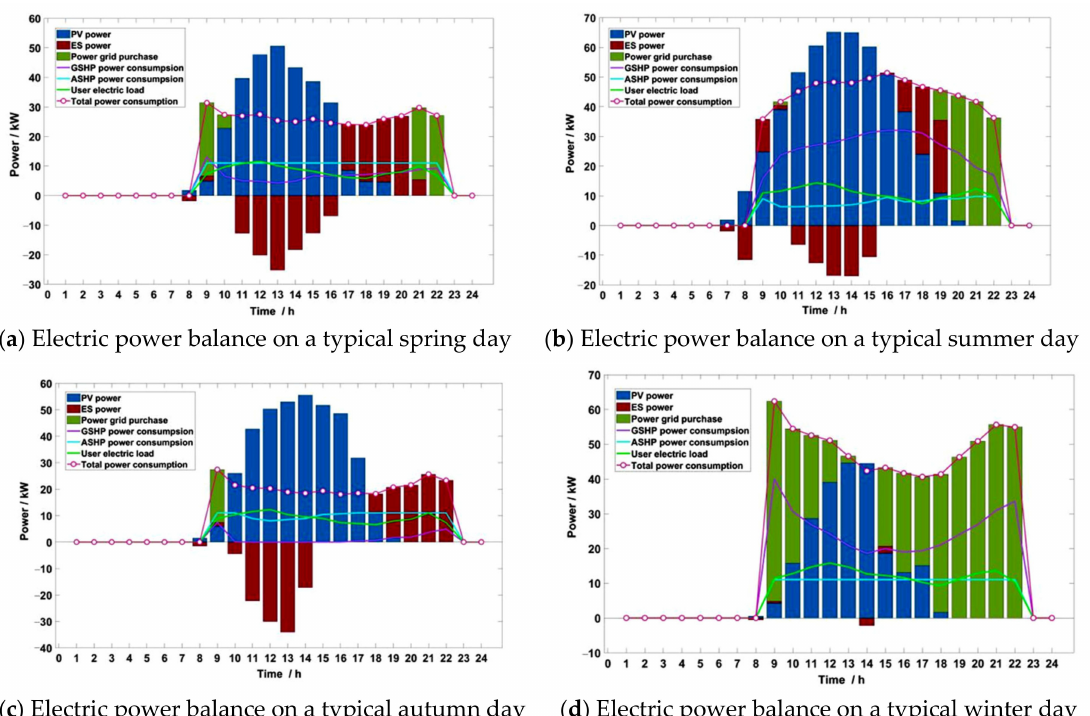
Figure 20. Typical daily power balance in the four